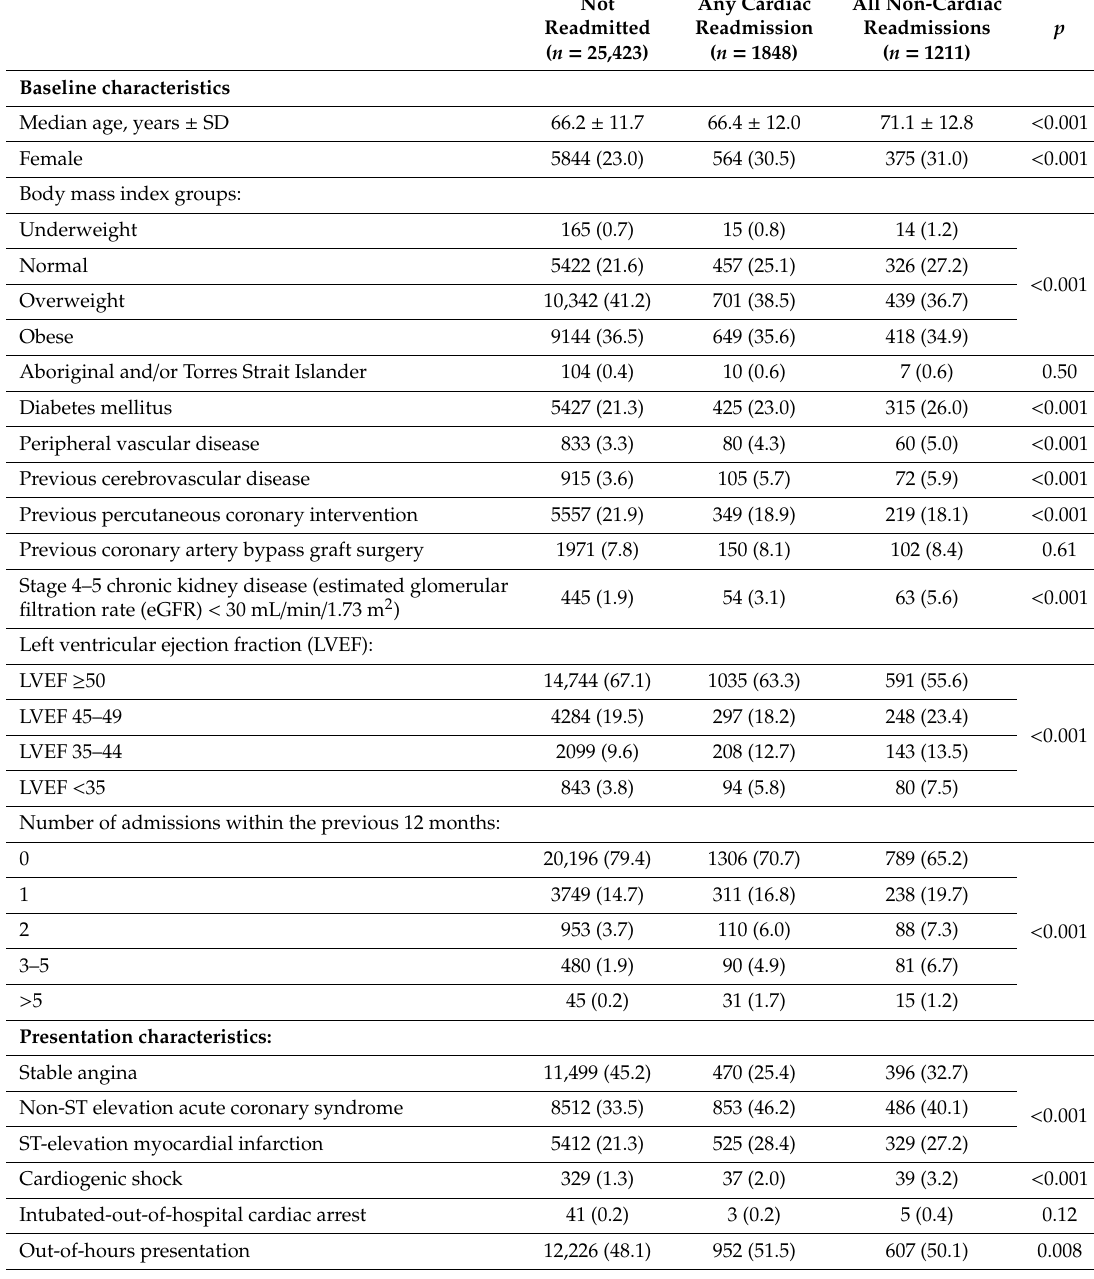
Table 1. Demographic and procedural characteristics by 30-day hospital readmission